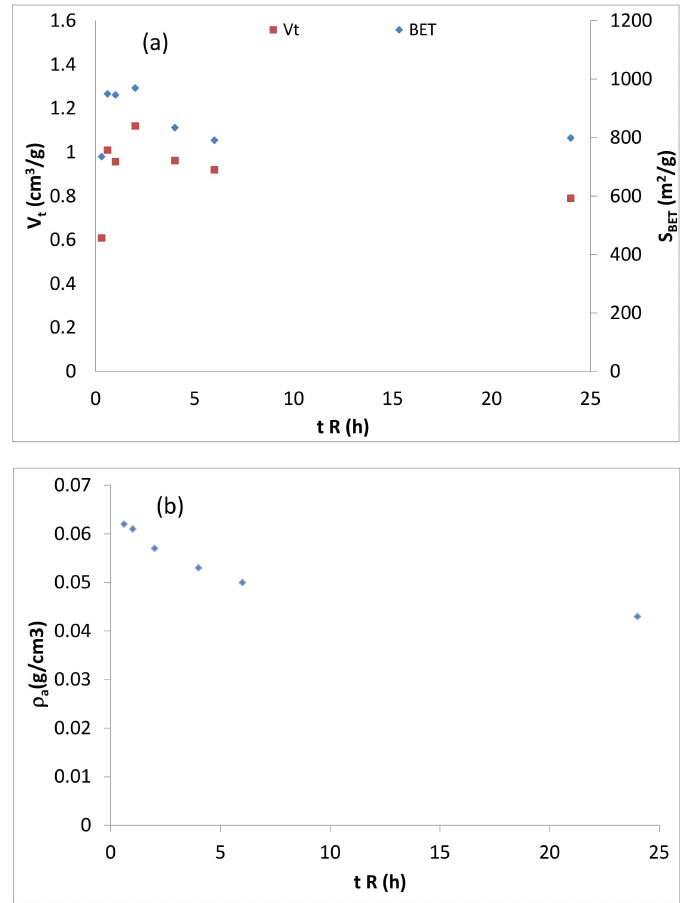
Figure 11. Variation with the reaction time of: ( a ) total volume (V t ) and BET area (S BET ) and ( b ) apparent density ρ a